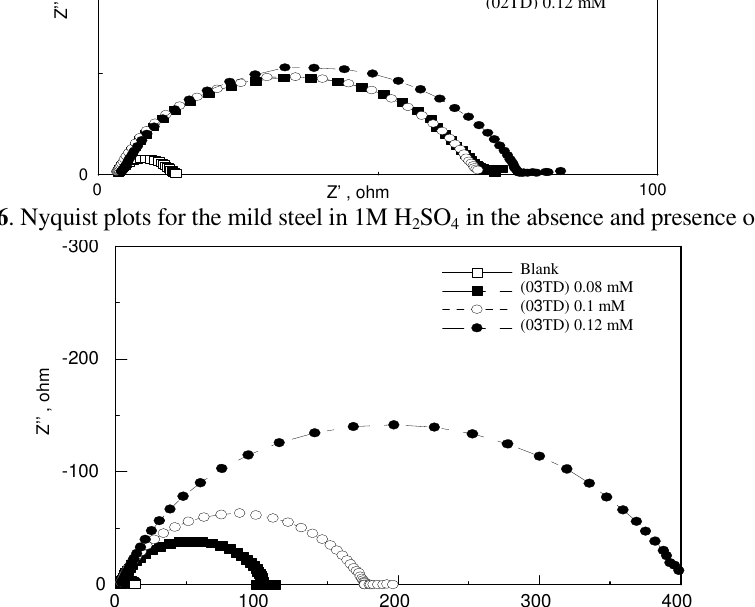
Figure 7 . Nyquist plots for the mild steel in 1M H